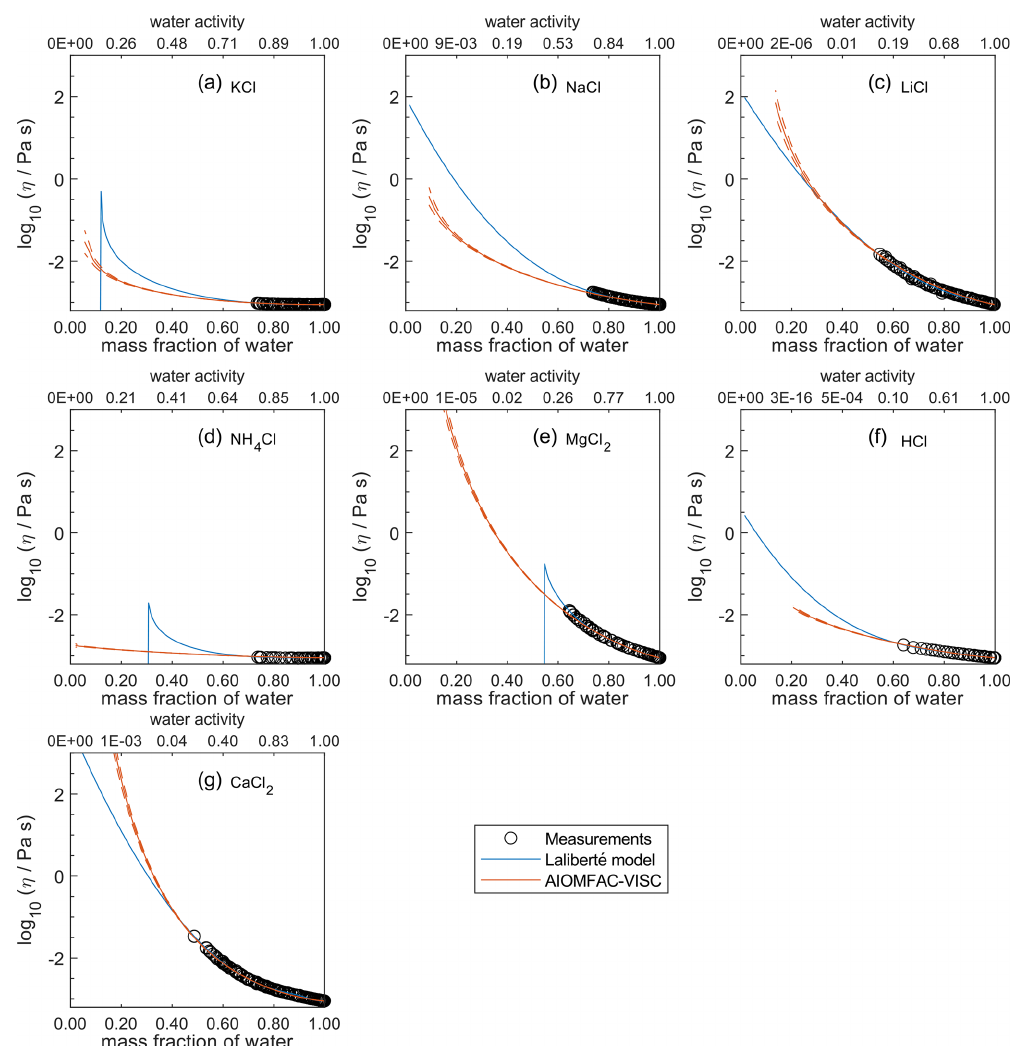
Figure 4. Comparison of the Laliberté model, AIOMFAC-VISC, and viscosity measurements versus mass fraction of water (bottom axis) and AIOMFAC-predicted water activity (top axis) for binary solutions of chloride salts at 298K with bulk measurements shown for 298 ± 1K: (a) KCl, (b) NaCl, (c) LiCl, (d) NH 4 Cl, (e) MgCl 2 , (f) HCl, and (g) CaCl 2 . See Fig. 2 for a zoomed-in version of this figure. Sharp discontinuities on the Laliberté model curve indicate extrapolation to non-physical values; extrapolated values should not be used beyond such points, which are outside of the valid concentration ranges provided by Laliberté (2007). AIOMFAC-VISC model sensitivity, defined by a ± 2% change in aerosol water content, is shown in red dashed curves. AIOMFAC-VISC predictions are not shown for concentrations corresponding to exceedingly low predicted water activity ( a w < 10 − 12 ), so the curve sometimes stops abruptly. Neither model accounts for potential crystallization of the solute (enabling predictions for extremely high ionic strengths). The values in the top axis are rounded to two significant digits. The data sources for the measurements are listed in Table